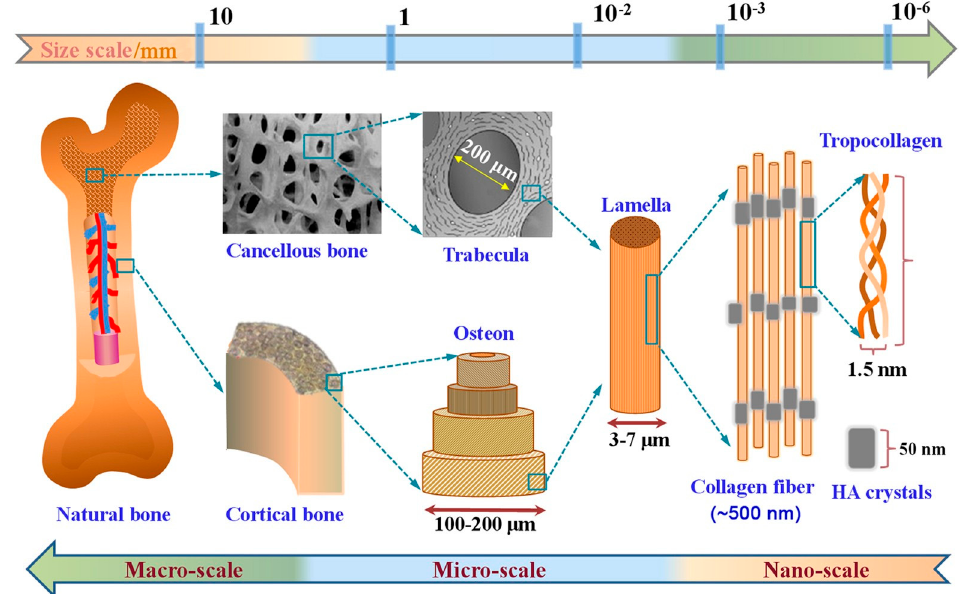
Figure 15. The bone hierarchical structure: cortical and cancellous bone, osteons with Haversian systems; lamellae; collagen fiber assemblies of collagen fibrils; bone mineral crystals (HA), collagen molecules, and non-collagenous proteins [248]. © Nature, 2017.